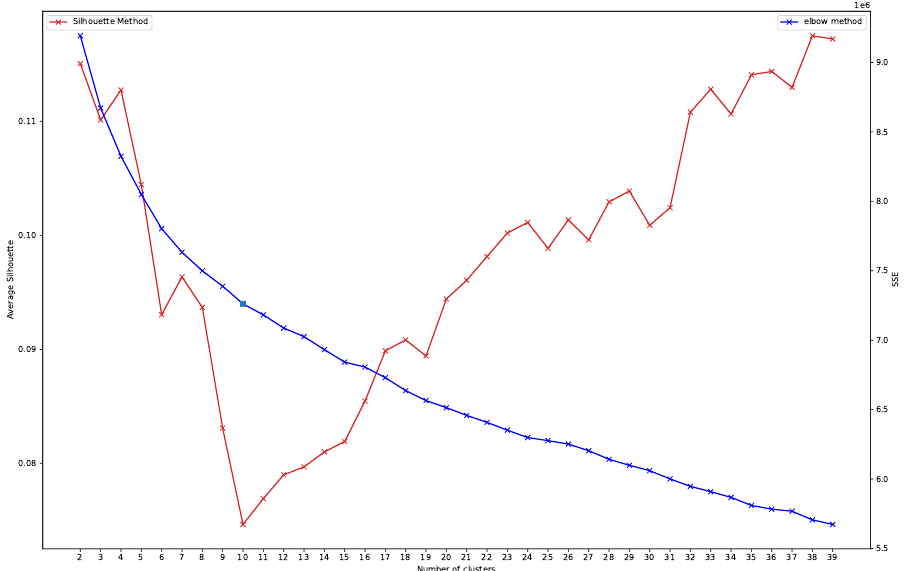
Figure 7. Graph of the SSE and Coefficient Silhouette vs. Number of clusters. We observe that the average silhouette diverges from the SSE curve after 20 clusters.